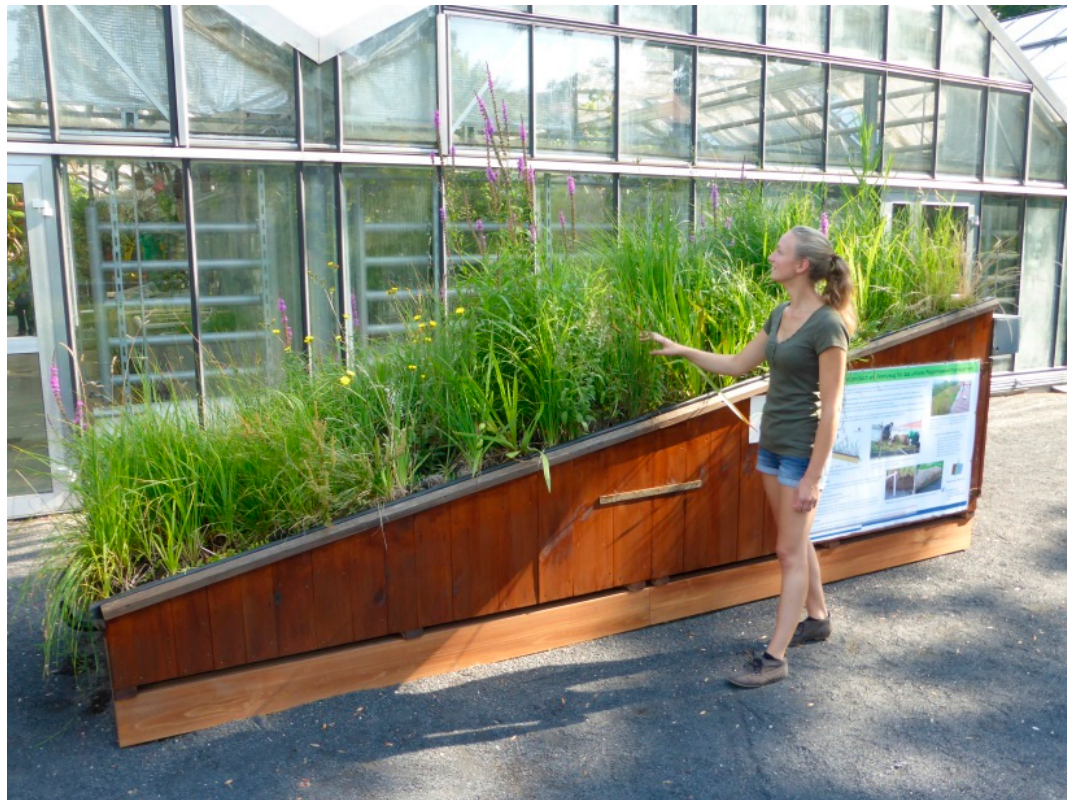
Figure 5 . Pilot plant system of a wetland roof (planted area 4.5 m²) (photo: Andreas Zehnsdorf) . Figure 5. Pilot plant system of a wetland roof (planted area 4.5 m 2 ) (photo: Andreas